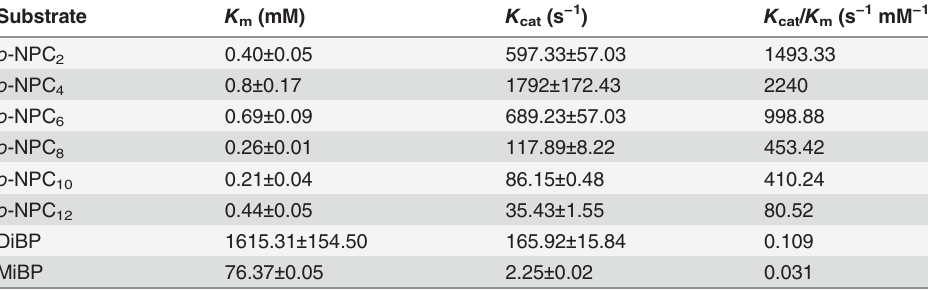
Table 1. Kinetic parameters of the recombinant CarEW on different substrates at pH 7.5 and 45°C.